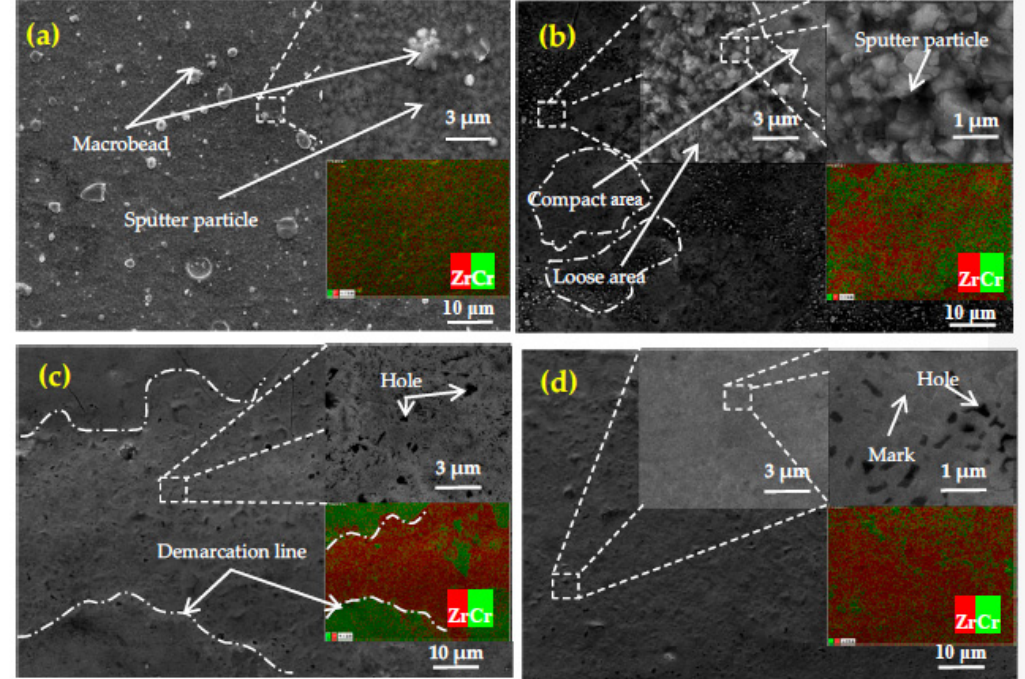
Figure 10. SEM and EDS for coating surface of sample No. 1 ( a ), sample No. 4 ( b ), sample No. 5 ( c ), sample No. 6 ( d ).